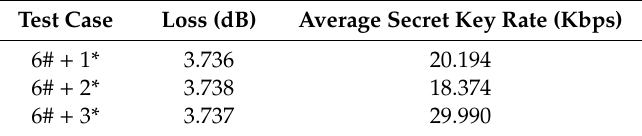
Figure 4. Test of connection loss (2# + 3# and 6#). Table 5. Connection loss based on light breeze.